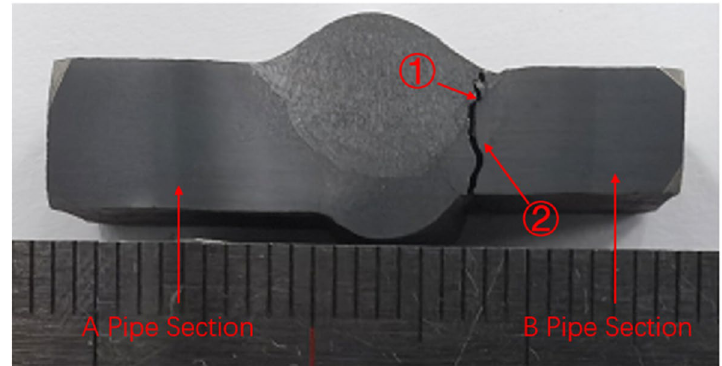
Fig. 14 Equivalent stress distribution at different weld